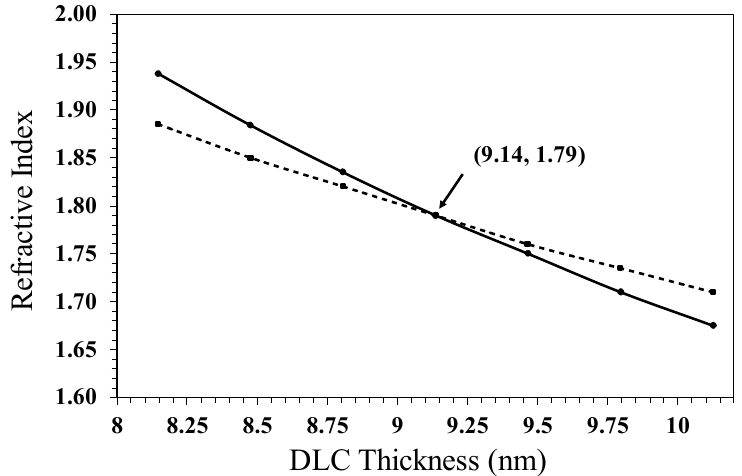
Figure 10. Examples of trial curves for simultaneous determination of the thickness and RI of DLC films using the graphical method for the sapphire prism/29.42 nm TiN/909.83 nm AlN sensor.